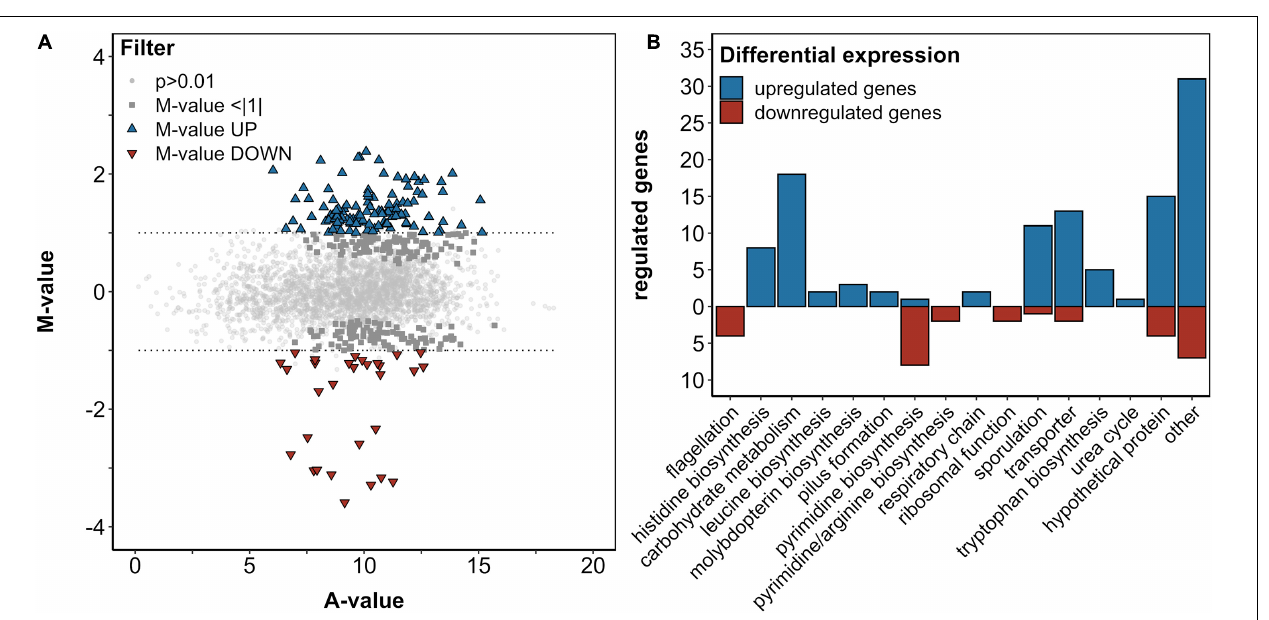
FIGURE 3 | Differential gene expression analysis of B. methanolicus WT in the presence and absence of 50 mM 5AVA (A) . The log 2 -transformed M/A plot reveals upregulated (UP; blue triangles) and downregulated (DOWN; red triangles) genes with an M -value > | 1|, which are categorized by function (B) . (A) Differential expression is below this threshold and non-differential expressions are indicated by dark gray squares and light gray circles, respectively. Cells were cultivated in MVcMY medium to the mid-exponential growth phase, and RNA was subsequently isolated, reverse transcribed to cDNA, and sequenced in biological triplicates. Differential expression was determined by DESeq2 with an adjusted p -value ≤ 0.01 according to the Wald test (Love et al.,